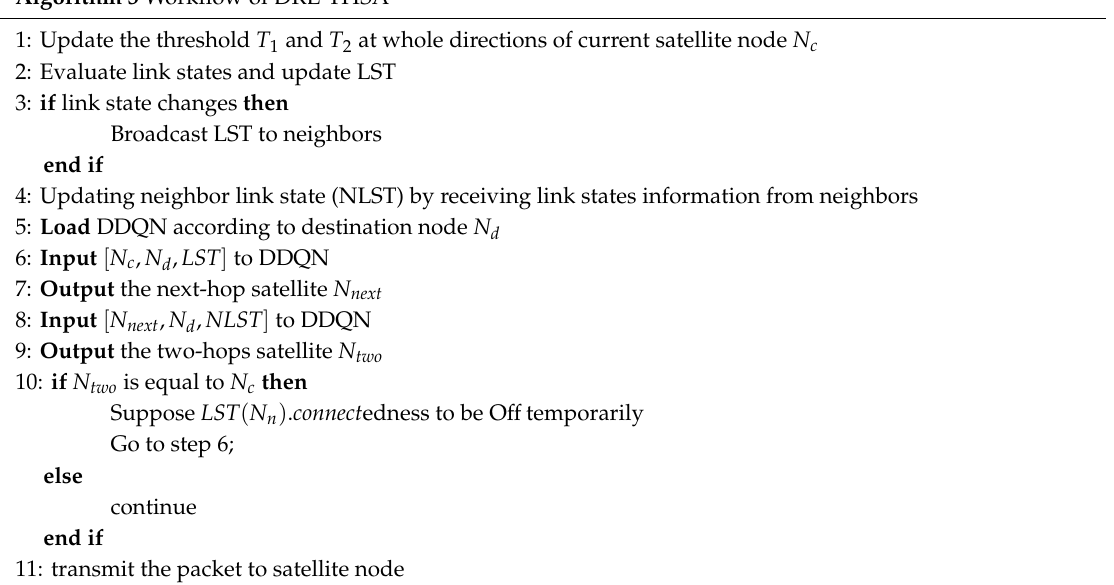
Algorithm 3 Workflow of